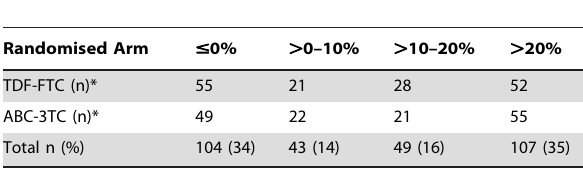
Table 2. Percent change in peripheral limb fat mass from baseline to week 96 expressed as quartile categories, based on randomised arm